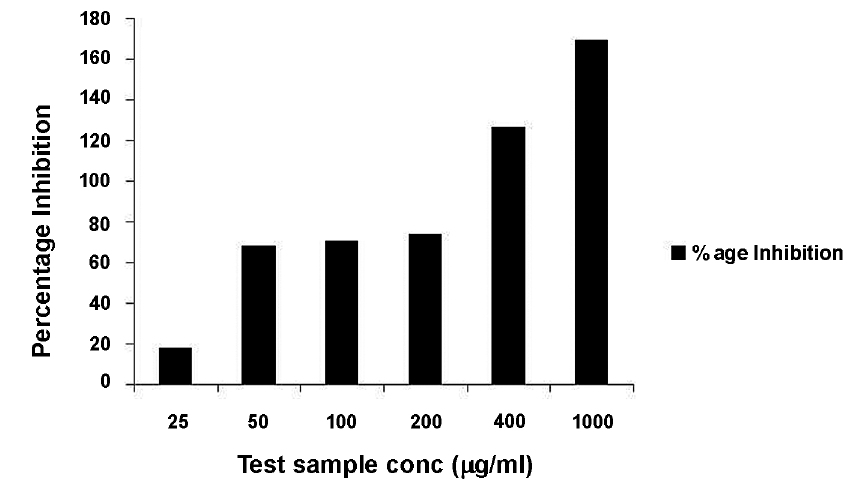
Figure 2 – Effect of Tribulus terrestris on the growth of